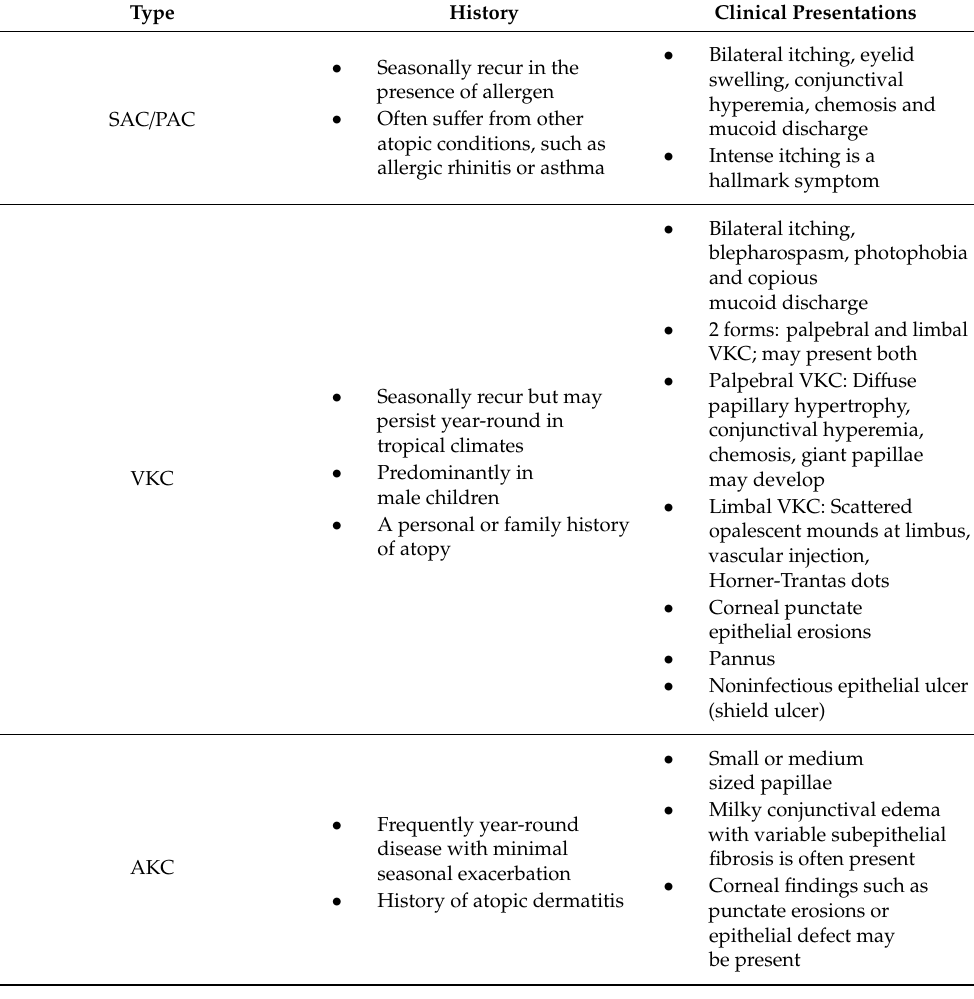
Table 1. Clinical presentation of di ff erent types of allergic conjunctivitis.